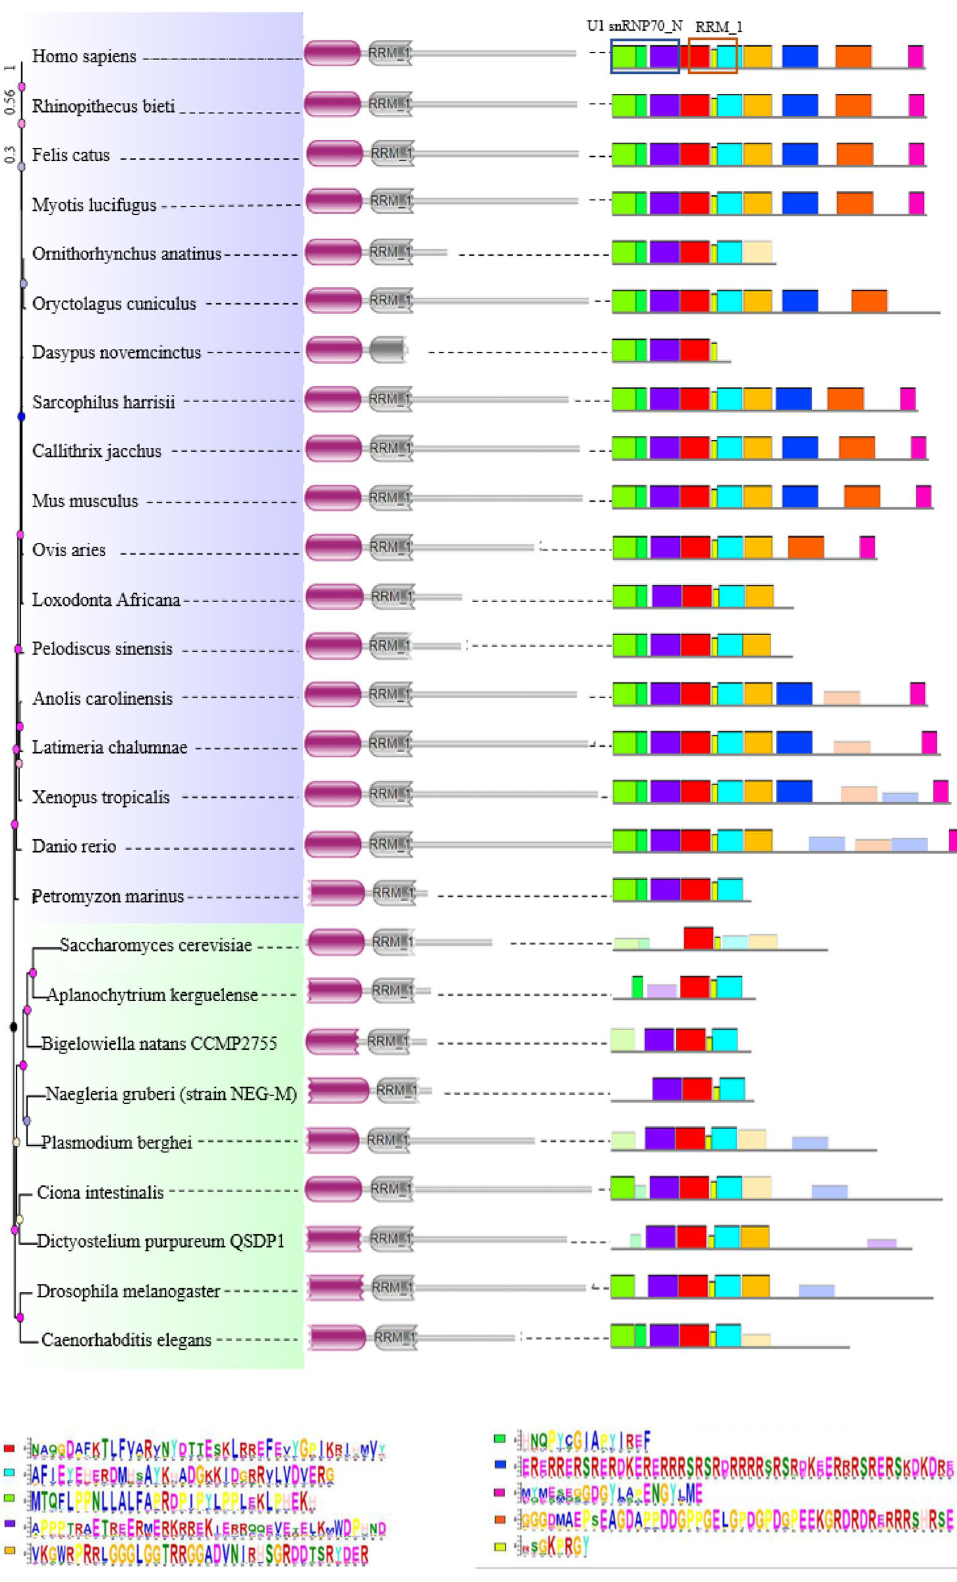
Figure 1. Protein motif analysis of representative animal U1-70Ks. The phylogenetic relationship is listed below. Protein regions predicted by online software HMMER are listed on the middle panel. Conserved motifs analyzed by MEME online tool are listed on the right panel. Top ten conserved motifs are represented by different colored boxes. For conserved motifs, the height of a box indicates the significance of the site (i.e. taller boxes are more significant). The correlation between major protein domains (middle panel) and conserved motifs (right panel) are shown in blue and red frames for U1 snRNP70_N and RRM_1 region,